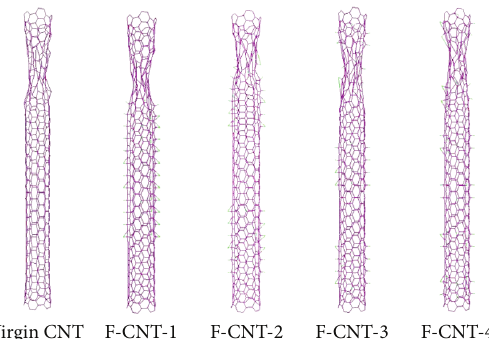
Figure 3: Tensile deformation of virgin CNT and functionalized